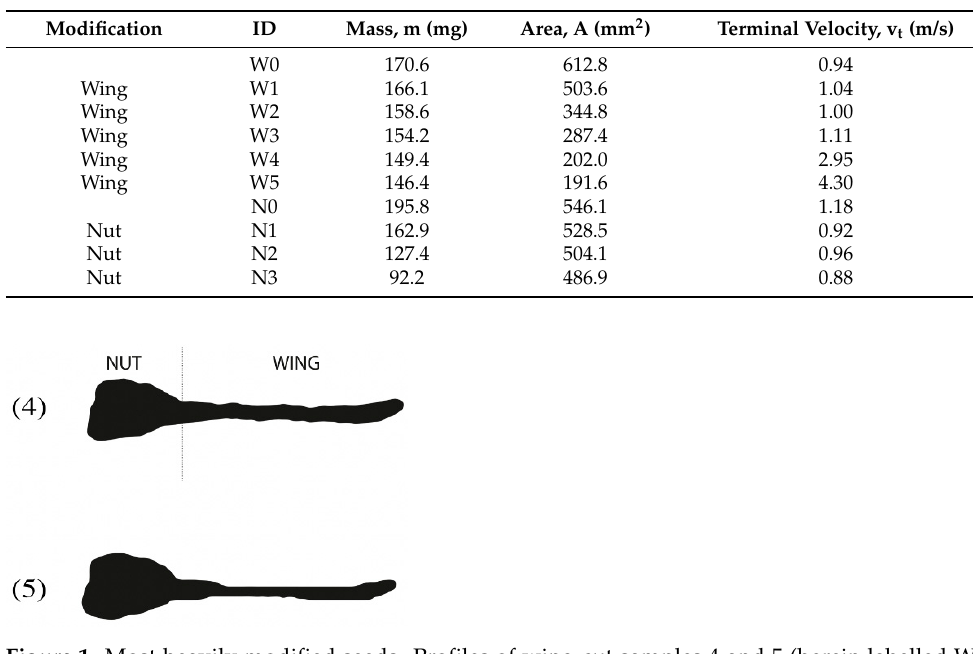
Figure 2. Sycamore seed results. Terminal velocity, v ₜ , is plotted as a function of intrinsic component, C int . Actual data points are shown as well as linear regression line covering data for samples N0 – N3 and W0 – W3 . 3.2. Venusian Gravity and Atmospheric Density Data has been obtained from the literature [14] for the density and temperature of the Venusian atmosphere (Figure 3). The key region of interest for VLF atmosphere sampling is the Venusian cloud layer between the cloud deck (VT) and the cloud base (VB). The atmos- pheric temperature is not immediately relevant to the flight model but is shown here since it does affect material selection. The acceleration due to gravity on Venus is ≈ 8.87 m/s².